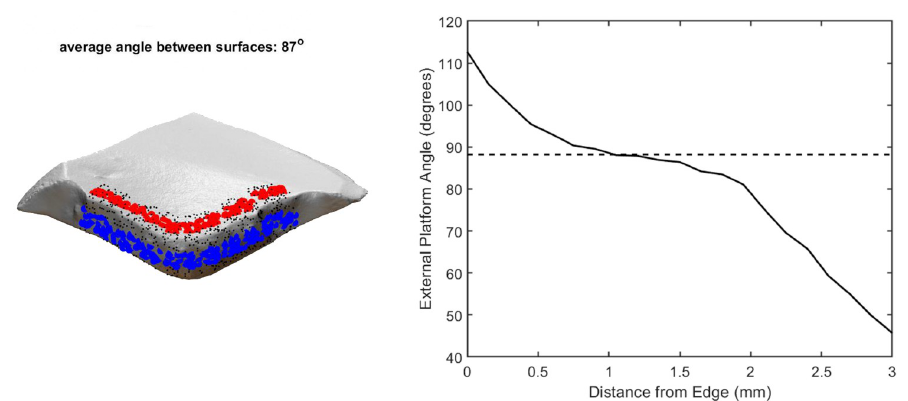
Fig 5. The external platform angle calculation showing the points at which angle is calculated on the platform (blue) and dorsal (red) surface (left), and a plot of the mean angle between the surfaces for different distances from the edge (–), as well as the mean angle returned by the software (—) (right).